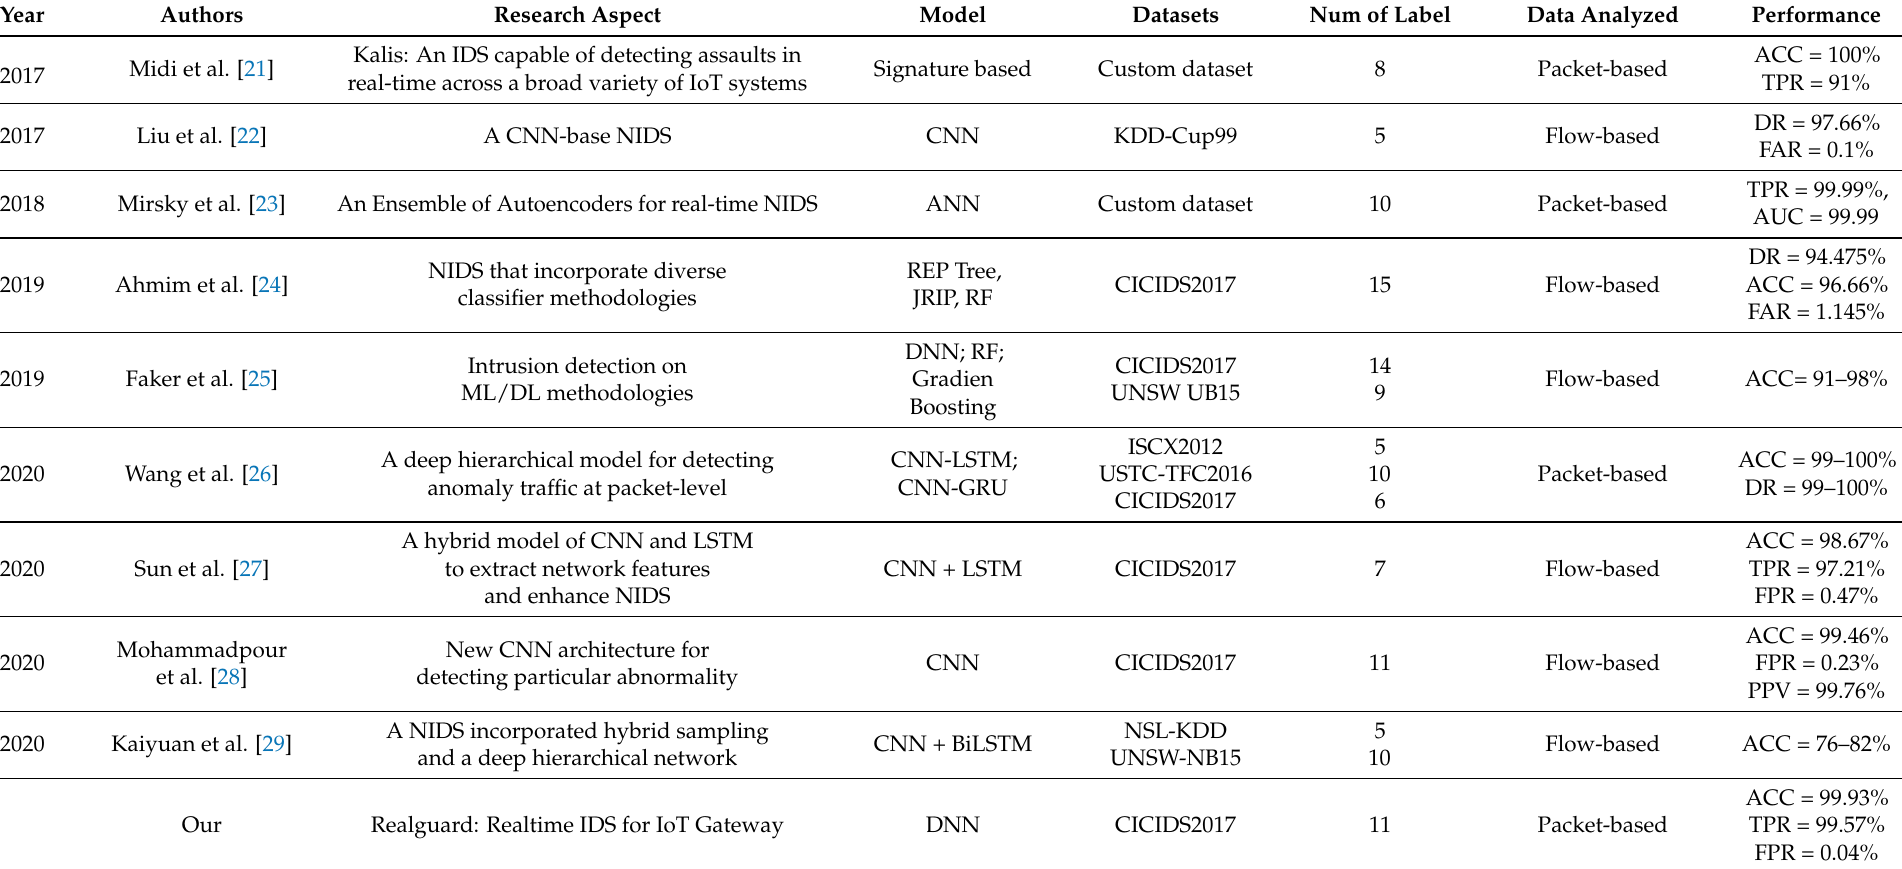
Table 1. The summary of related works on